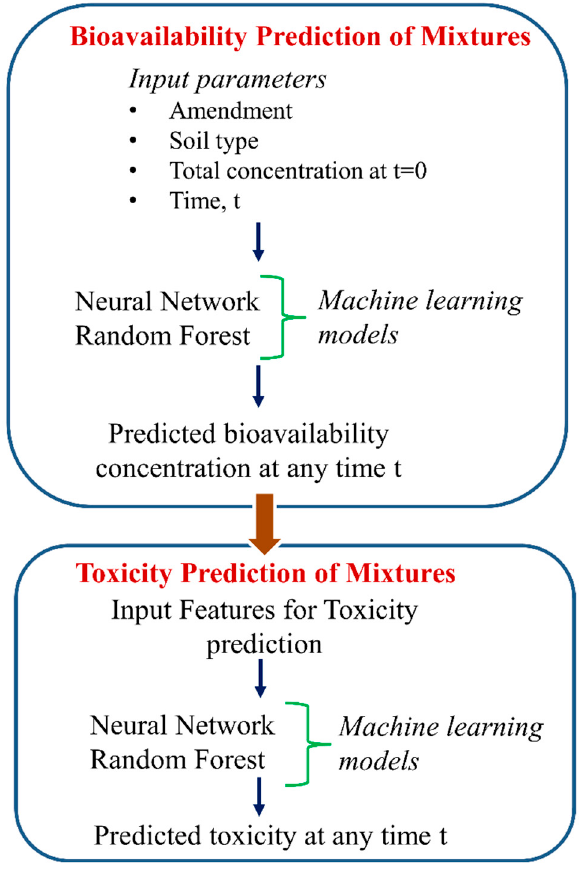
Figure 7. Prediction of soil toxicity by two-stage approach employing bioavailability.